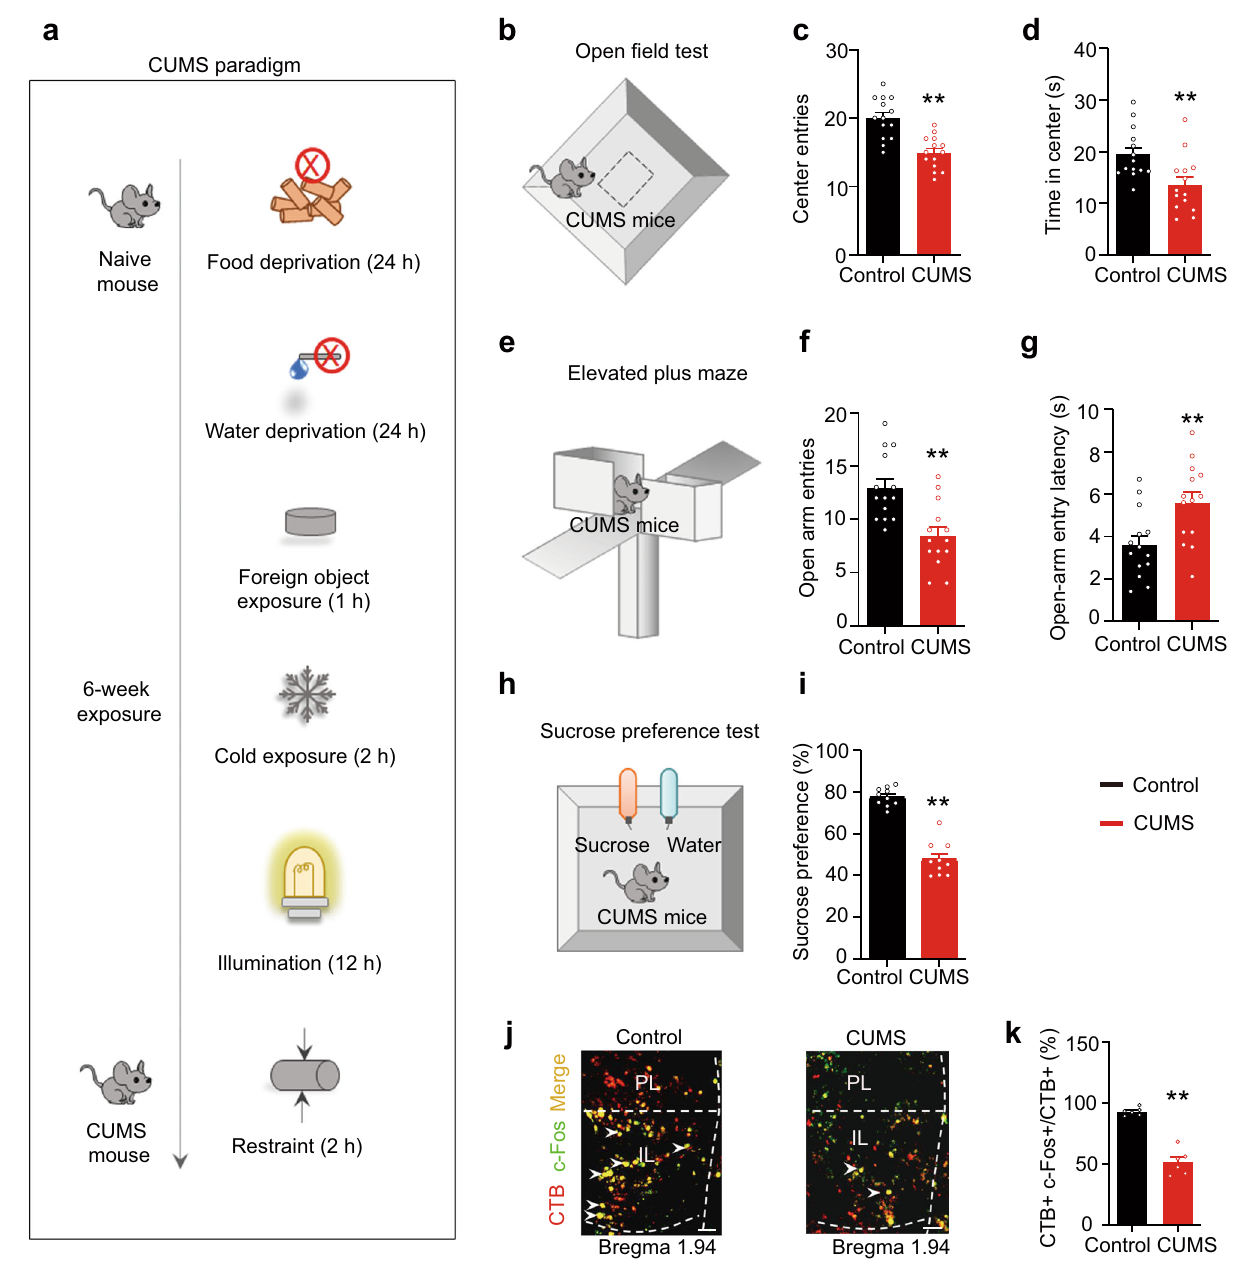
df =26, P =0.0007;[Open-armentrylatency] t =2.996, df =26, P =0.0059. i InSPT, the CUMS mice showed less sucrose preference than the control mice. Two-sided unpaired t test, t =10.30, df =18, P <0.0001. n =10micepergroup. j Representative co-staining of CTB+/c-Fos+ neuronsinthe ILshown by pBLA injection of CTB(red) and measured at 90min after EPM. Scale bar=100 μ m. k The percentage of both CTB+ and c-Fos+ over CTB+ was signi fi cantly decreased in CUMS group than controls. n =6 mice per group. Two-sided unpaired t test, t =9.341, df =10, P <0.0001. ** P <0.01 vs Control. Data were presented as mean±SEM. Source data are provided as a Source Data fi